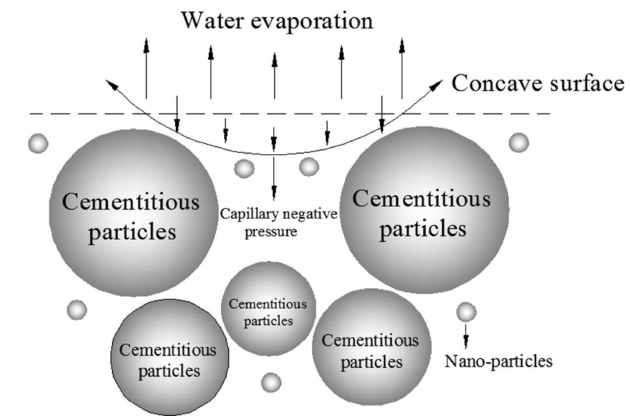
Figure 5. Force simulation of air-liquid meniscus. Reproduced from [36], with permission from Elsevier,